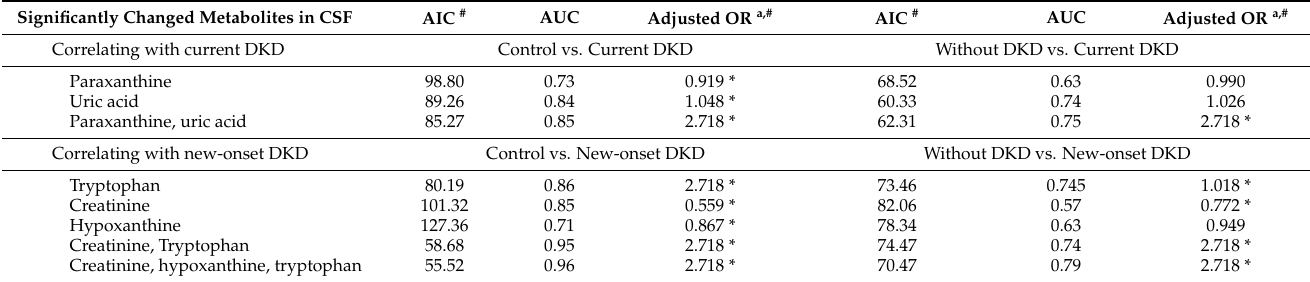
Table 4. Association of the metabolite combinations in the CSF samples from patients with diabetic kidney disease with current DKD or new-onset